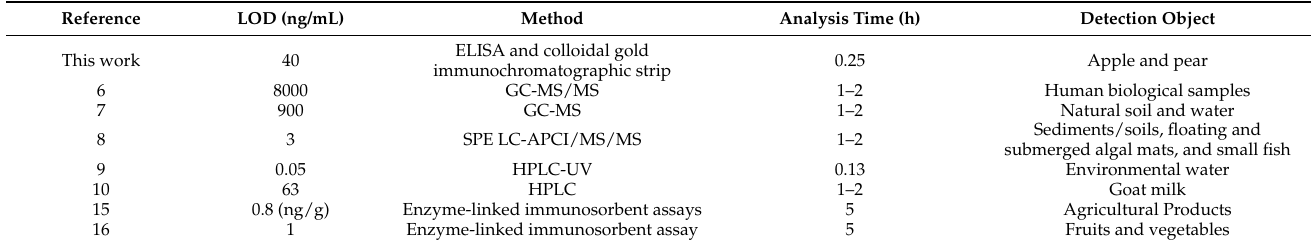
Table 6. Comparison of this method with other measurement